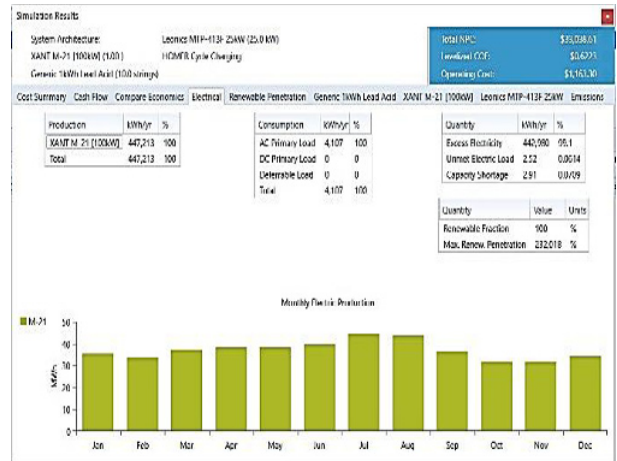
Fig. 3 . The results by HOMER of XANT M-21